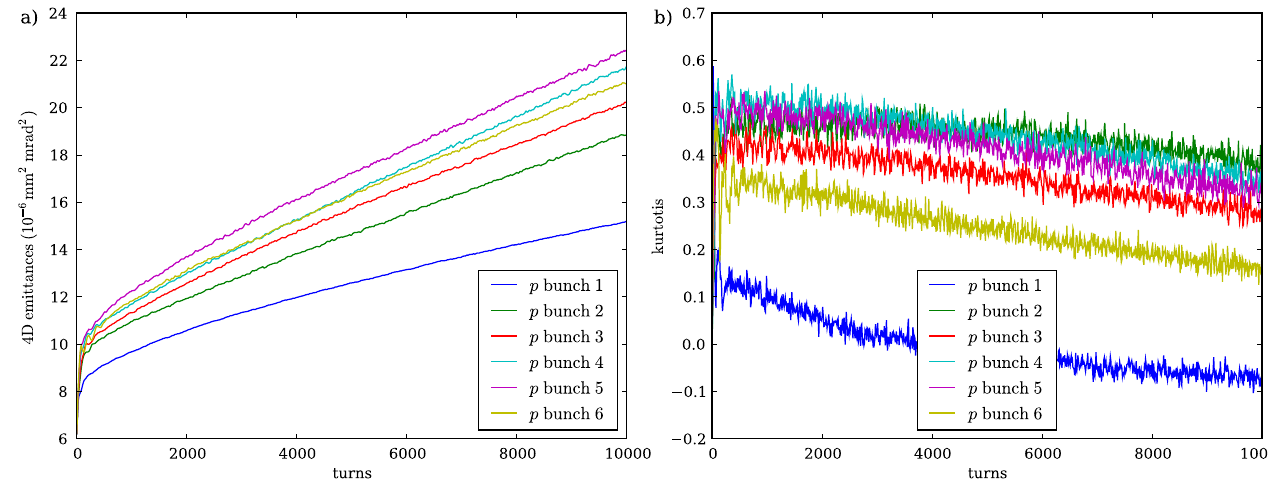
FIG. 14. (Color) A six-on-six bunch Tevatron run with 8 : 8 (cid:2) 10 11 particles/bunch: (a) The turn-by-turn evolution of 4D emittance of each of the six bunches. (b) The turn-by-turn evolution of y kurtosis of the six